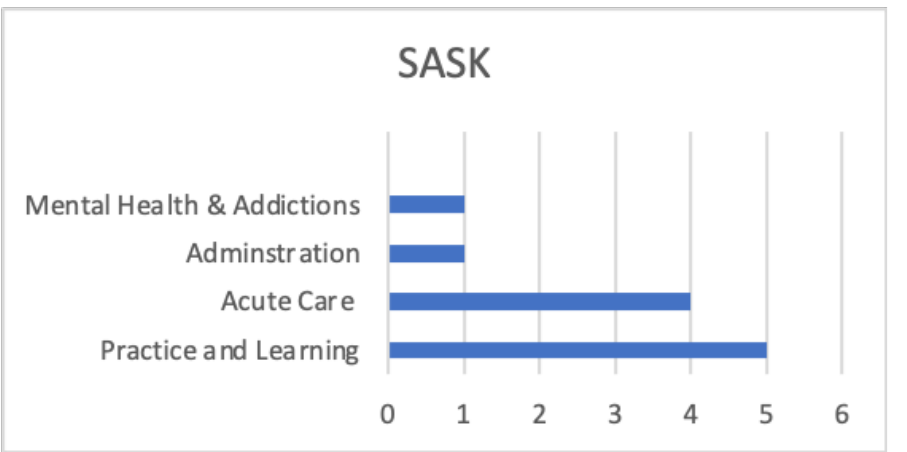
Figure 5: Place of Nurse